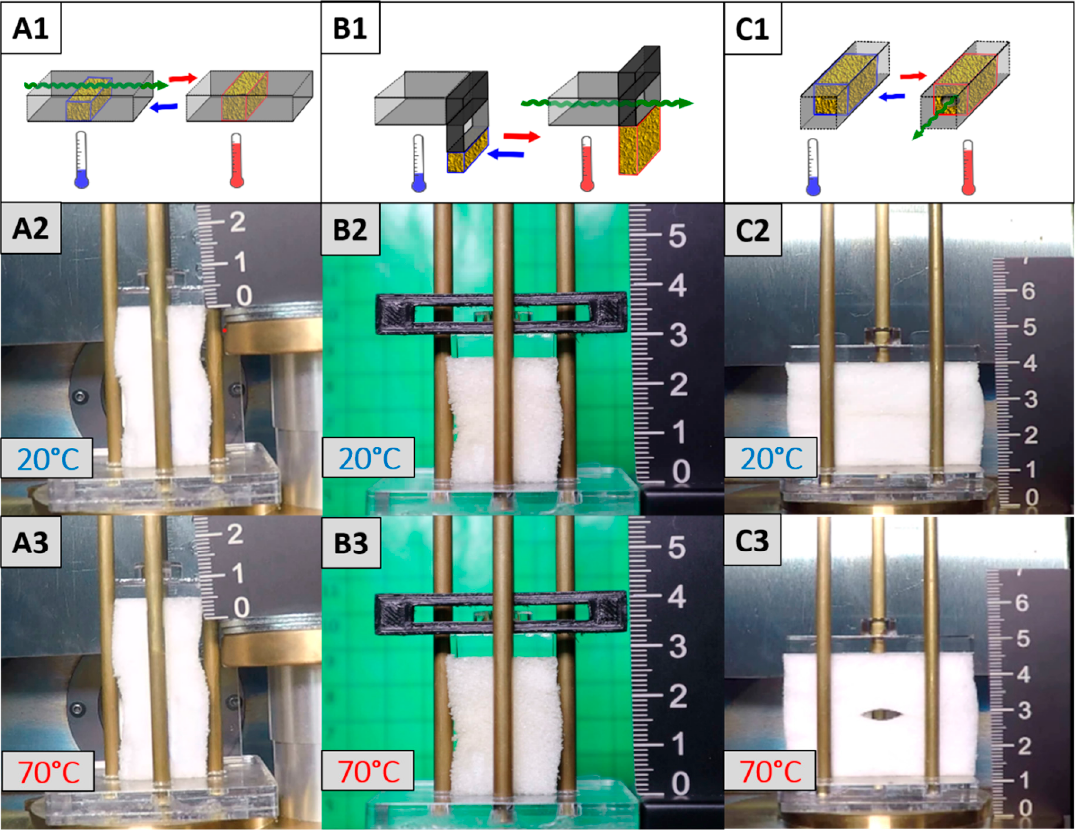
Figure 12. Schematic representation for the foam actuator concept of first ( A 1), second ( B 1) and third generation ( C 1) and pictures of the corresponding demonstrators in their boundary states at T low ( A 2, B 2, C 2) and T high ( A 3, B 3, C 3). For the sake of simplicity, the weight on the foam is not shown.